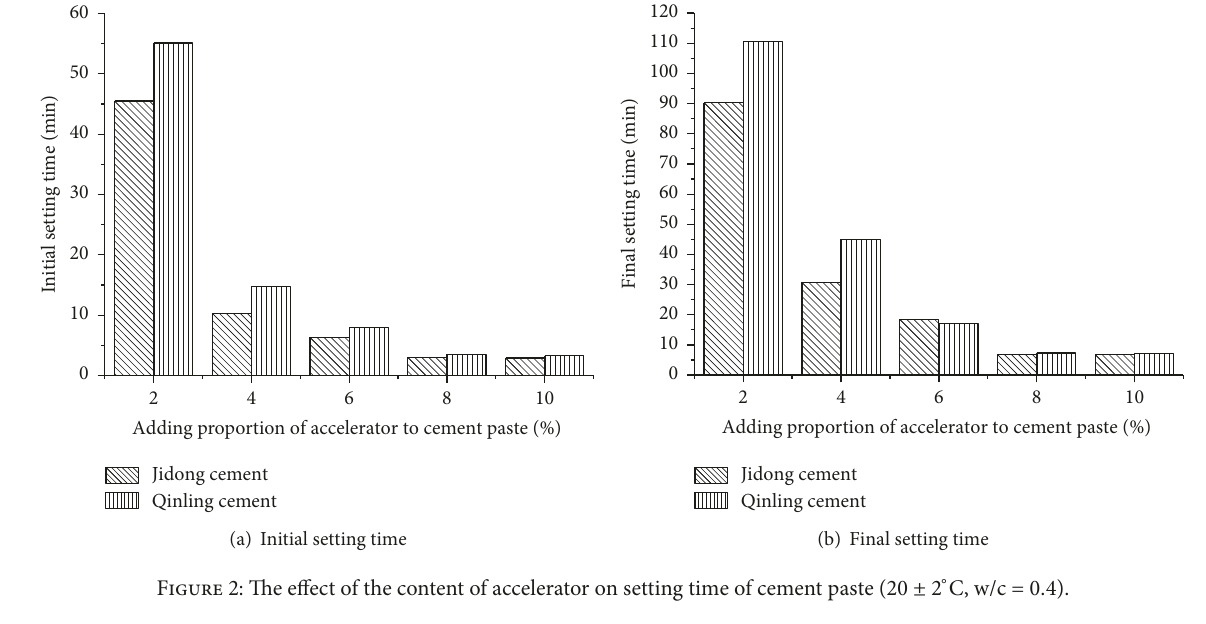
Figure 2: The effect of the content of accelerator on setting time of cement paste (20 ± 2 ∘ C, w/c = 0.4).